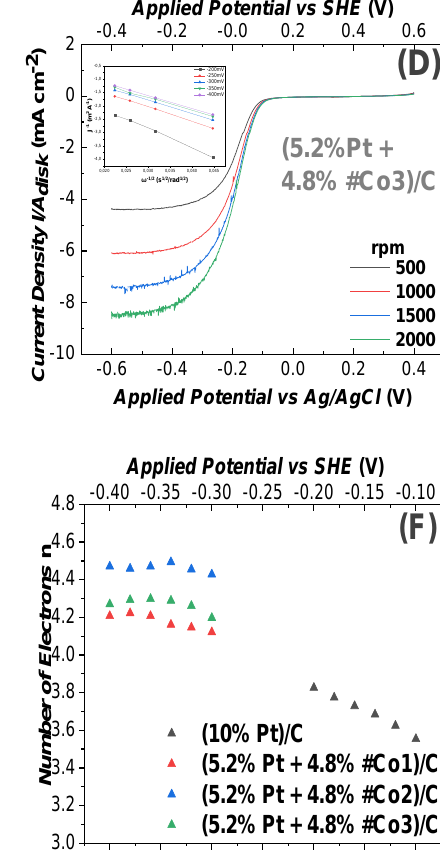
Table 2. Comparison of ORR performance of the present FSP-Nanocatalysts vs. literature data for Co-based catalysts. Catalysts on